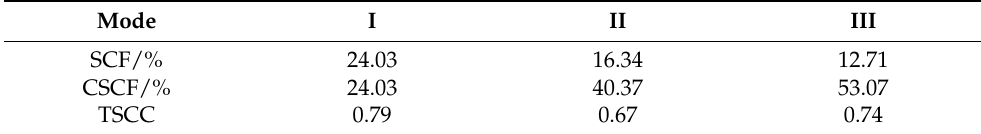
Table 3. The first three modes of SVD analysis and their SCF, CSCF, and TSCC between HMA winter snow depth and summer scPDSI in the